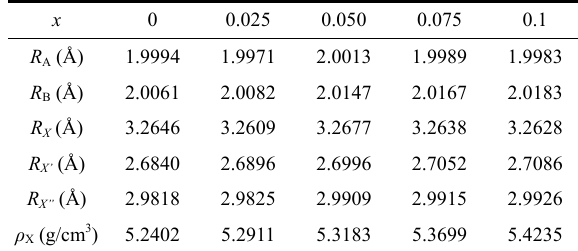
Table 2 Variation of average ionic radius, theoretical lattice parameter, oxygen positional parameter, and